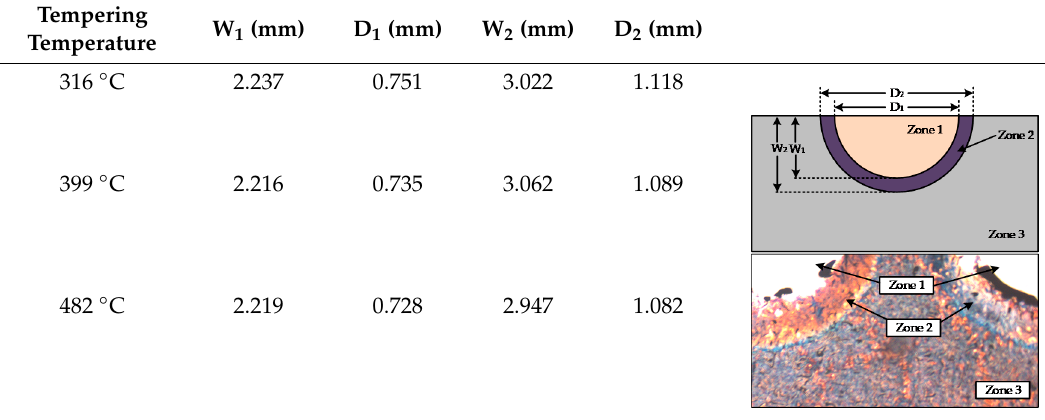
Table 5. Width and Depth of Laser-Hardened and Heat-Affected Zones for LHQTGI Specimens with Various Tempering Temperatures.